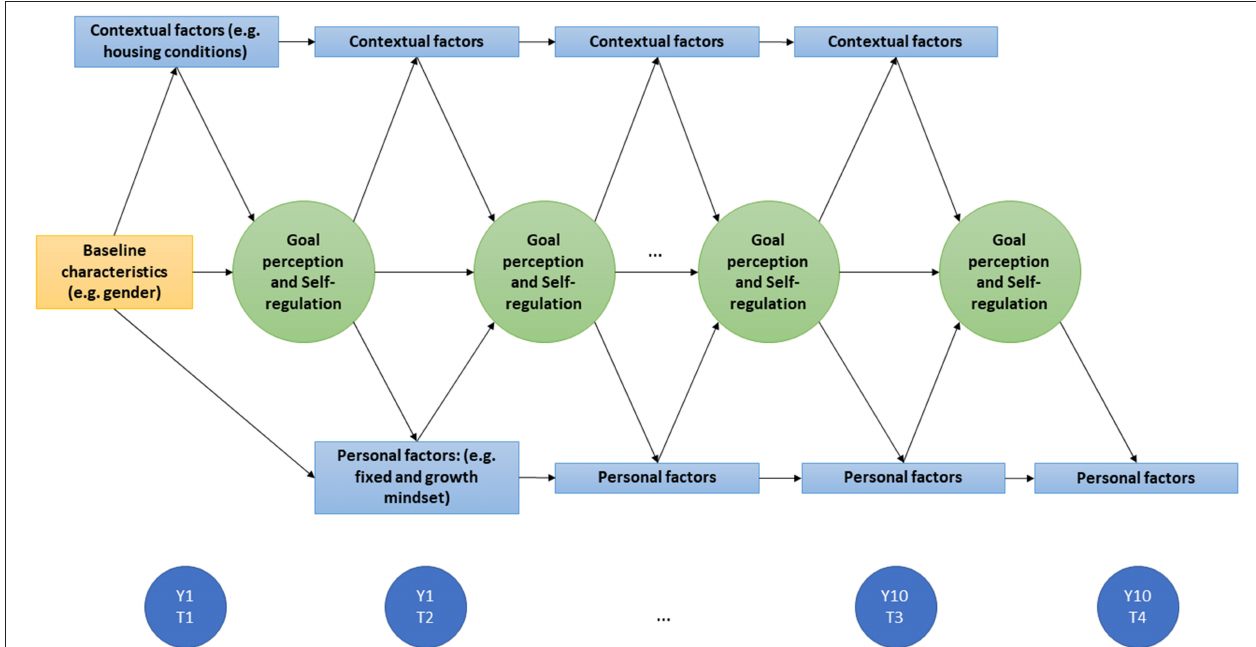
FIGURE 1 | Dynamic model of all factors measured in the 10YUP cohort, showing the expected underlying relationships.